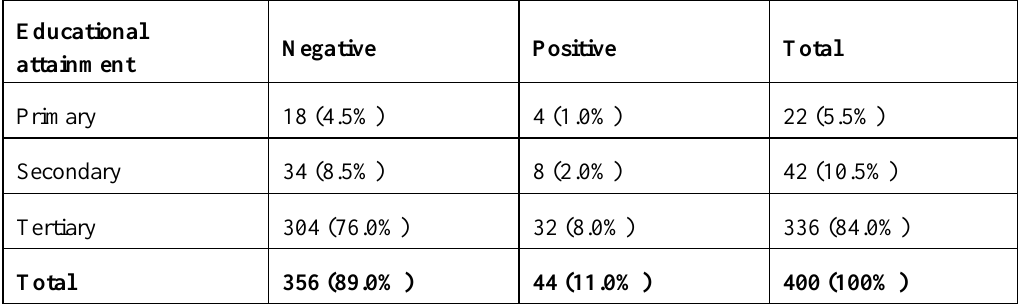
Table 6. Association between educational status and hepatitis B status among pregnant women in Ilorin.